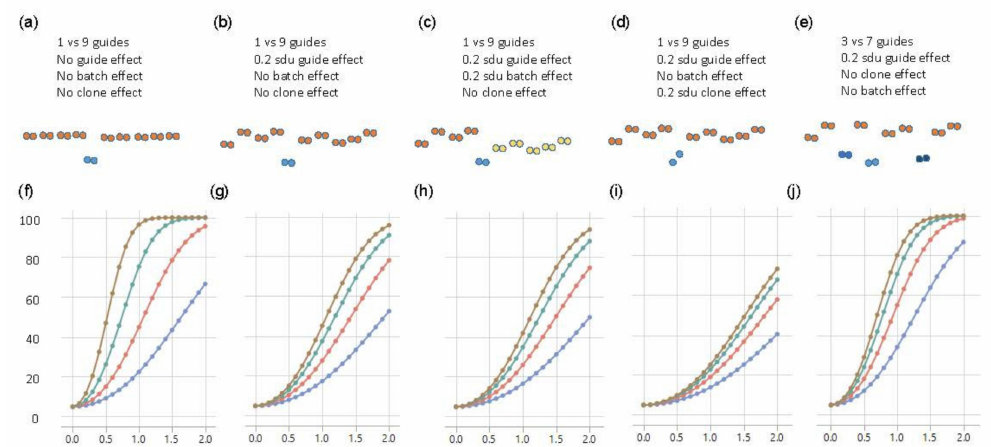
Figure 4. Power curves of Fluidigm-based single-cell clone regulatory assessment of simulation studies. ( a – e ) diagrams of five di ff erent scenarios and the corresponding panels ( f – j ) show the power calculations for exceeding a nominal p -value of 0.05, with blue, red, green, and brown curves representing 2, 4, 8, and 16 technical replicates of each clone, respectively. The y -axis is the power from 0 to 100 percent, and the x -axis is the e ff ect size of eQTL in the standard deviation